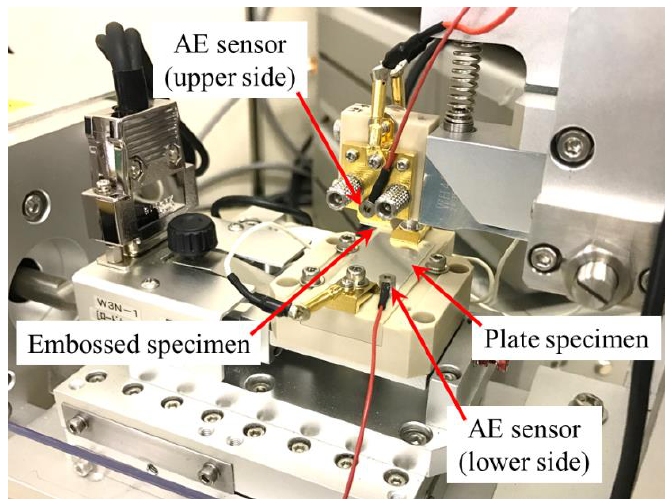
Figure 1. Appearance of the experimental setup.